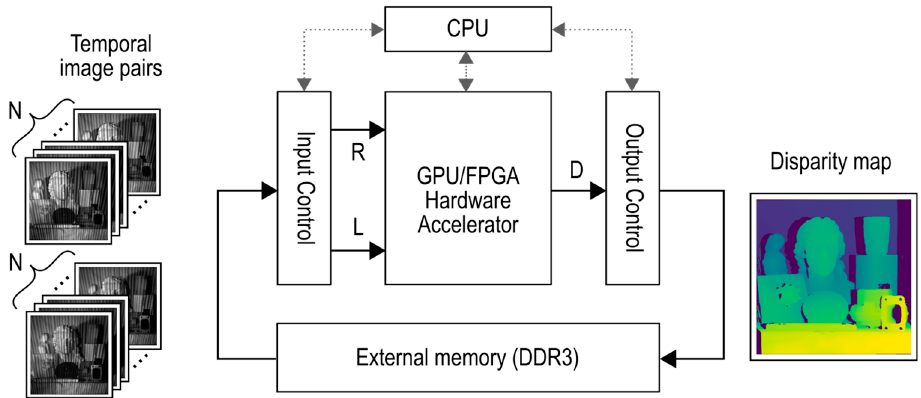
Figure 8. Experimental test setup using GPU or FPGA as the computing platform.